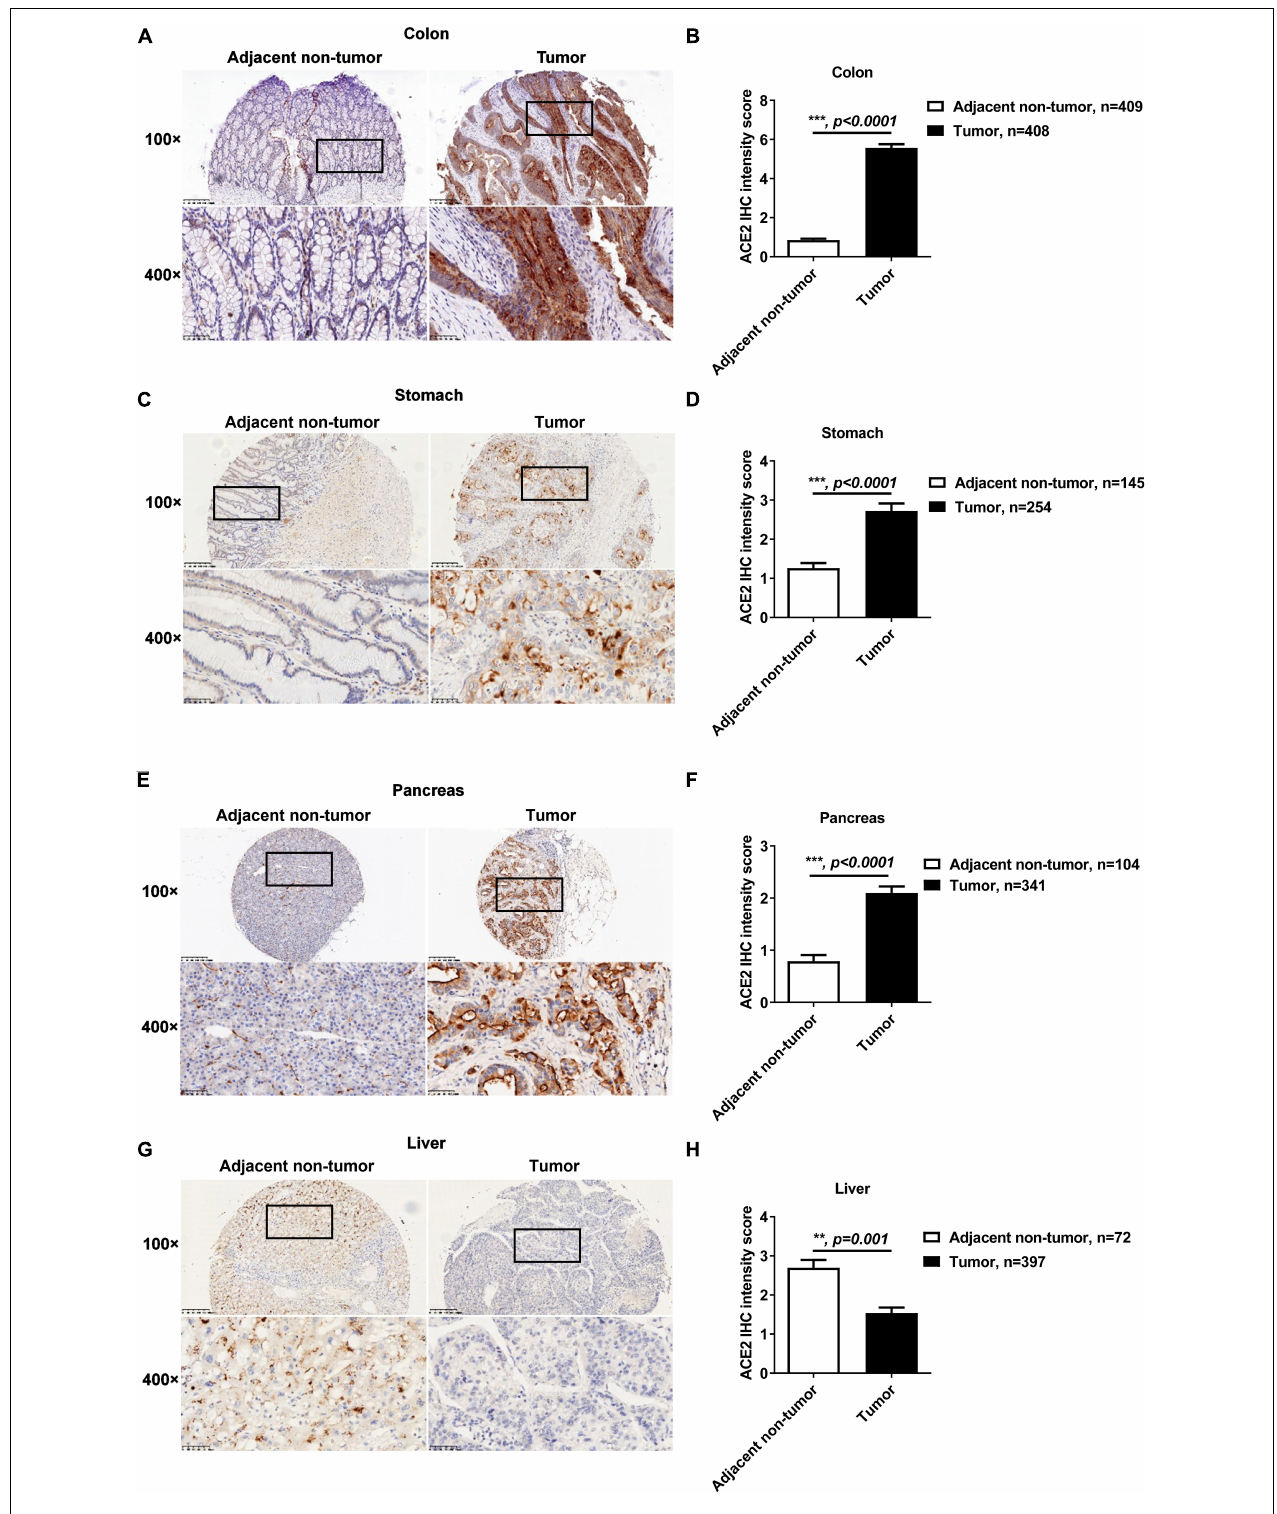
FIGURE 2 | The protein expression of ACE2 was increased in colon, gastric, and pancreatic cancer but decreased in liver cancer. The protein expression of ACE2 in colon cancer, gastric cancer, pancreatic cancer, and liver cancer tissues and their adjacent non-tumor tissues was determined by IHC. (A,B) Increased ACE2 expression in colon cancer tissues. (C,D) Increased ACE2 expression in gastric cancer tissues. (E,F) Increased ACE2 expression in pancreatic cancer tissues. (G,H) Decreased ACE2 expression in liver cancer tissues. Scale bar, 200 µ m (100 × ) and 50 µ m (400 × ). Data are shown as the mean ± SEM (B,D,F,H) .